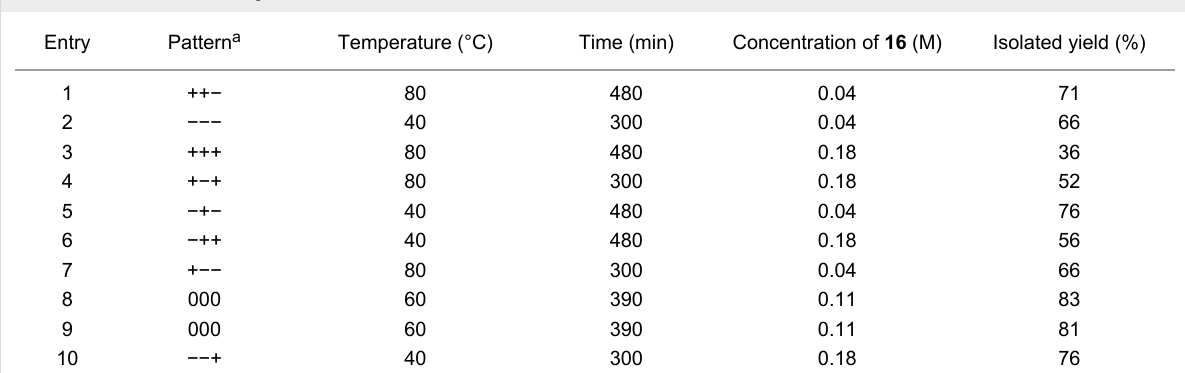
Table 3: 2 nd Factorial screening for 16